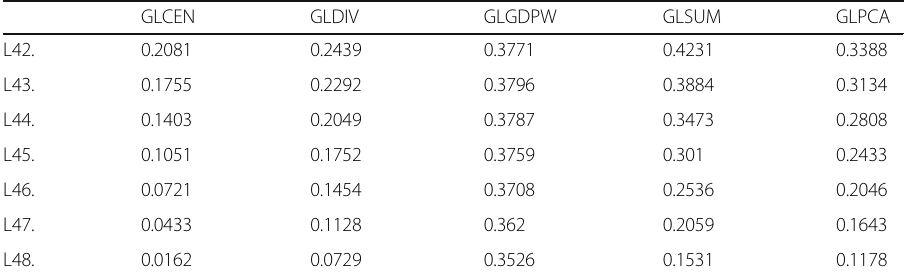
Table 1 Correlation between Cyclical Components of GREA and Lags of the Cyclical Components of Various Measures of Global Liquidity (Continued) GLCEN GLDIV GLGDPW GLSUM